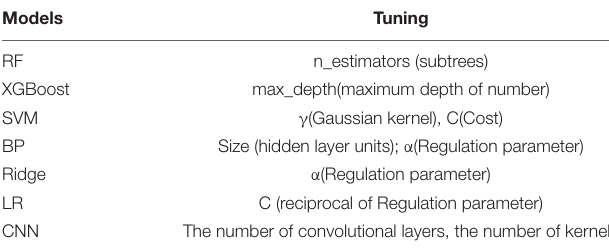
TABLE 2 | Tuning parameters of the seven models.